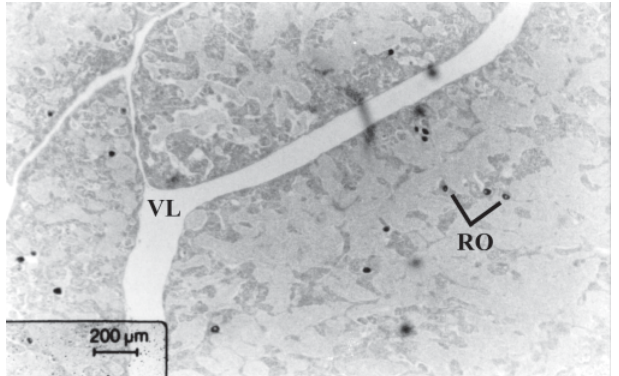
Fig. 12. Transverse section of the testicle of Mycteroperca bonaci showing the vestigial lumen (VL) and remaining oocytes (RO) in its interior. Stain: H.